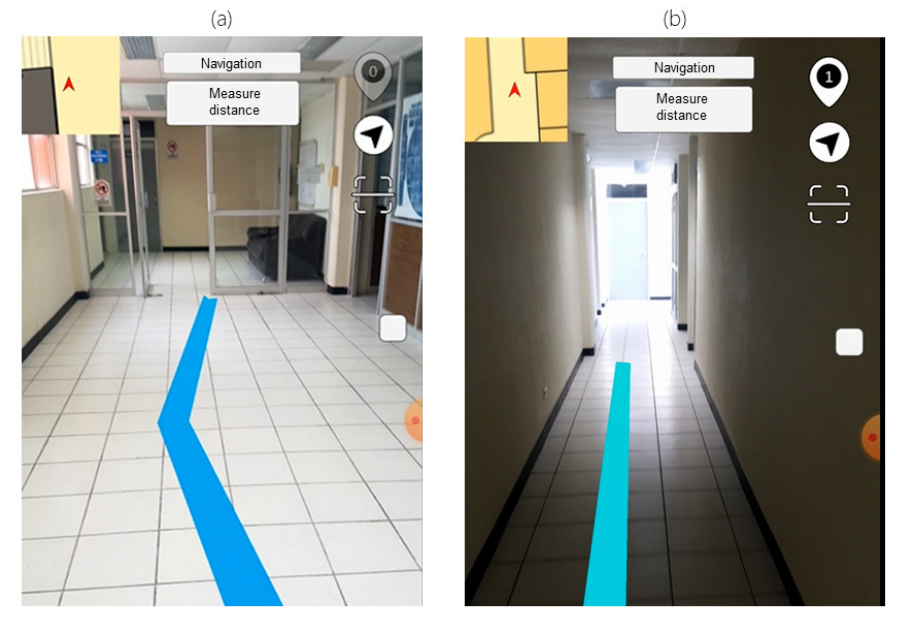
Figure 17. Comparison of routes. ( a ) Route with good illumination and environmental characteristics. ( b ) Route with low illumination and few environmental